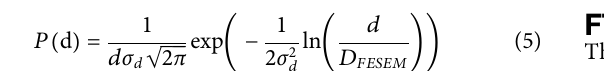
Frontiers in Materials |